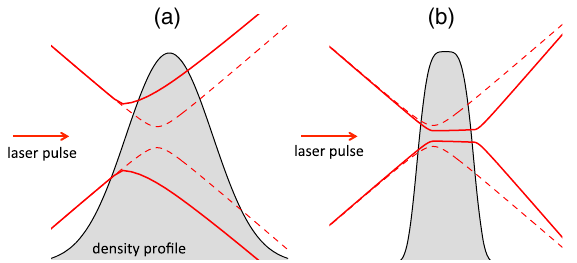
FIG. 1. Schematic of beam propagation issues in microscale jets. The dashed line represents the vacuum laser beam whereas the full line shows the beam size considering plasma effects. (a) The density gradients are large compared to z R preventing the laser beam from reaching high intensity in the jet. (b) With sharper density gradients, coupling into the jet is optimized and the laser beam can reach higher intensities through self-focusing.